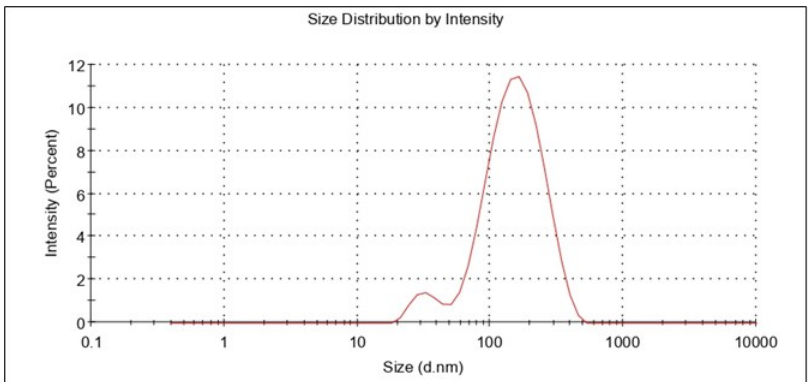
Figure 5. Representative plots for globule size of the developed nanoemulsion.